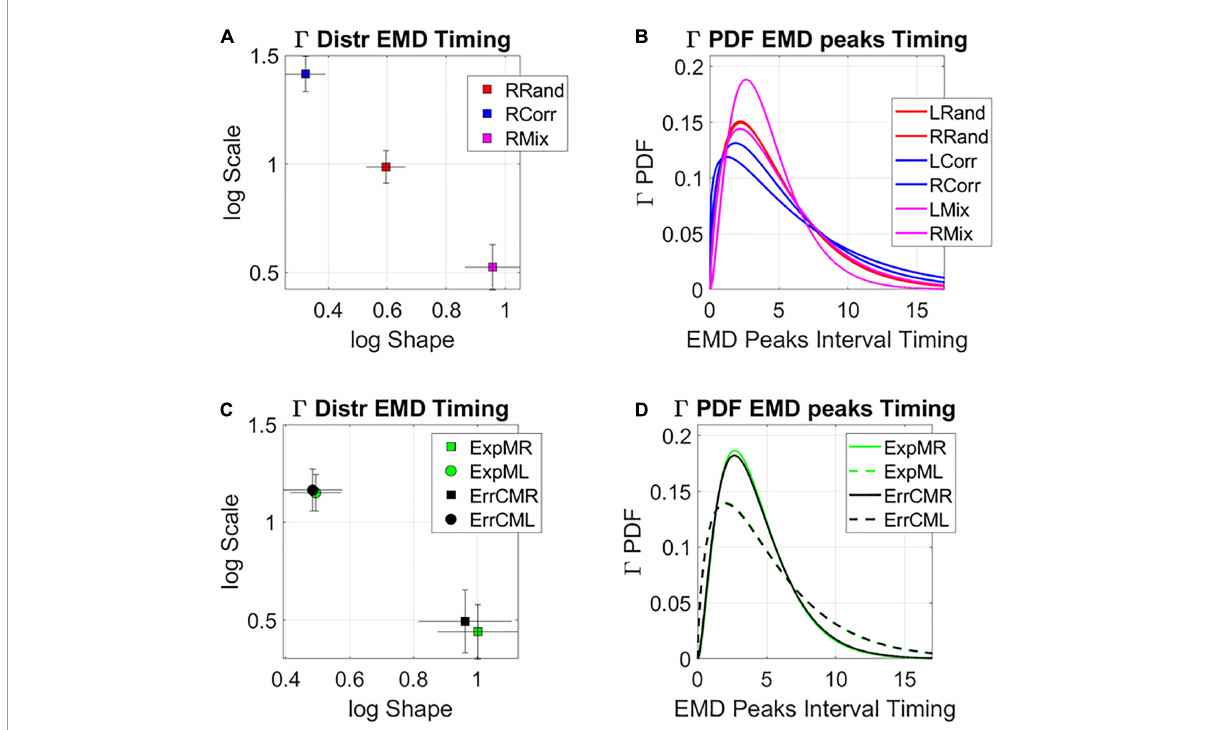
FIGURE10 Global statistical learning dynamics. Unfolding the global rate of change in distribution shapes, as the system transitions from PDF to PDF, using the EMD to ascertain distribution differences from moment to moment. (A) Right target case is shown for the three groups with 95% confidence intervals for the empirically estimated Gamma shape and scale parameters. Each point represents a different distribution. Here the mixed group shows the maximal values of log shape (Gaussian) and SNR (1/log scale). (B) The PDFs corresponding to the maximum likelihood estimation (MLE) distributions in (A) . (C) Investigating the differentiation between targets for the two subgroups of the mixed condition at the global level reveals similar rate of change in the interpeak intervals, suggesting smooth transitions in both exploratory and error corrective cases. (D) Corresponding PDFs for (C)